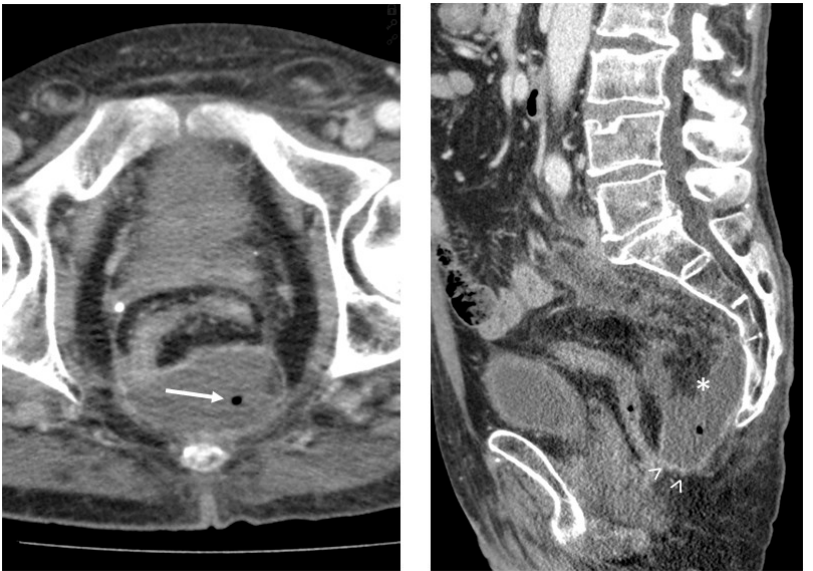
Figure 2. A 63-year-old man with presacral abscess (*), demonstrating gas entrapment ( → ), wall enhancement (>), fat stranding and CT attenuation of 29 HU. Microbiology after percutaneous drainage confirmed infection.